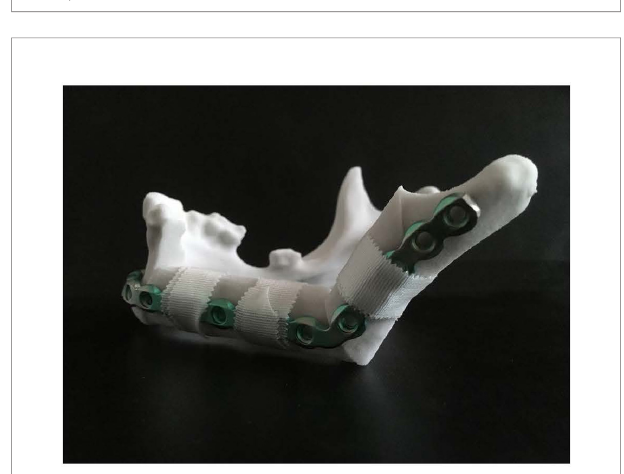
FIGURE 3 | Frontal view of a 3D model of the virtual planned reconstruction in Proplan CMF.